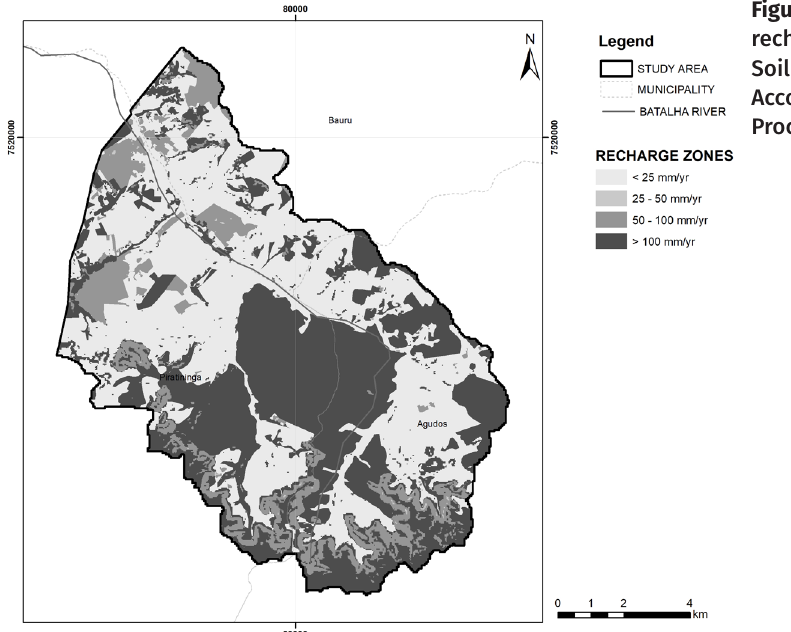
Figure 4. Aquifer recharge using Soil Moisture Accounting Procedure